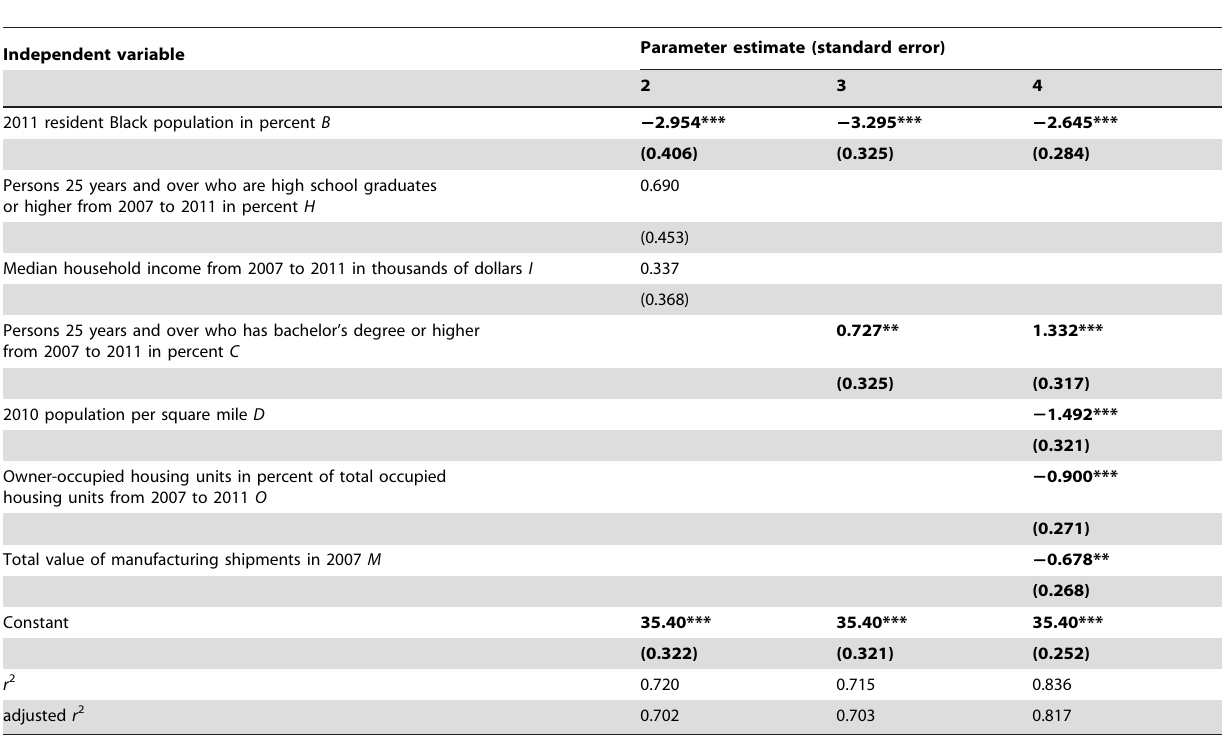
Table 3. Multiple regression of median utterance length with US Census Bureau QuickFacts variables as possible